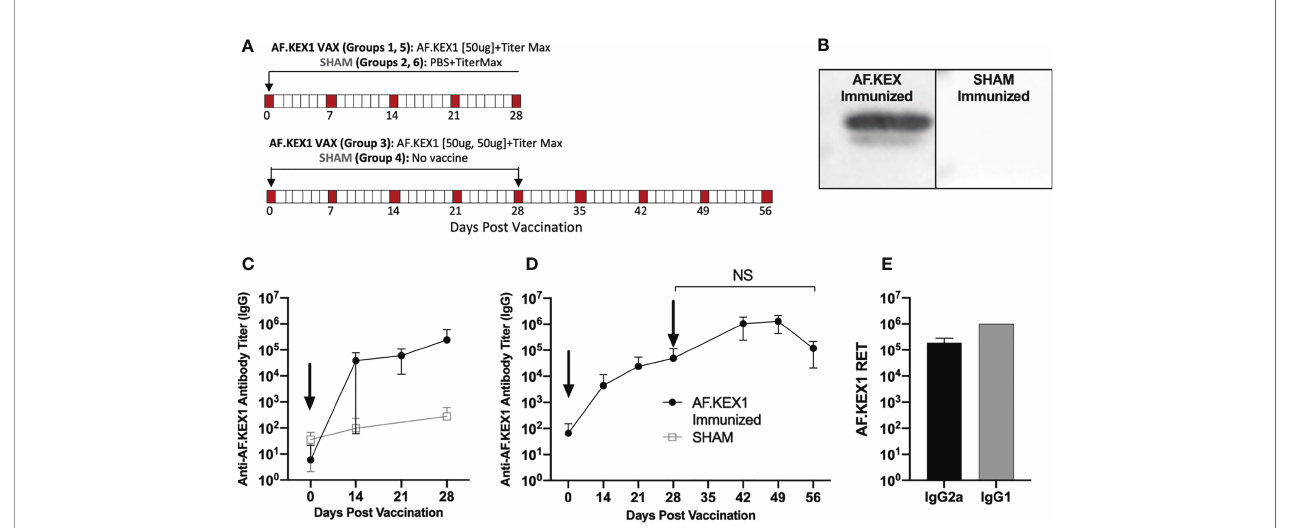
FIGURE 2 | AF.KEX1-speci fi c humoral responses following A. fumigatus challenge and AF.KEX1 immunization in mice. (A) Schematic of vaccinations for all mice. (B) Western blots of recombinant AF.KEX1 protein using plasma from mice 28 days post vaccination with AF.KEX1+TiterMax or PBS+TiterMax. (C) Mean plasma AF.KEX1-speci fi c immunoglobulin G (IgG) titer, as determined by enzyme-linked immunosorbent assay of a single immunization or (D) two immunizations with AF.KEX1 +TiterMax and PBS+TiterMax. (E) IgG2a (Th1) and IgG1 (Th2) antibody levels in pooled plasma from AF.KEX1+TiterMax-immunized mice. Vaccinations are indicated with arrows. Mann-Whitney rank tests were performed to compare data baseline to data and all post-vaccination timepoints were p <.0001, compared with baseline. NS, not signi fi